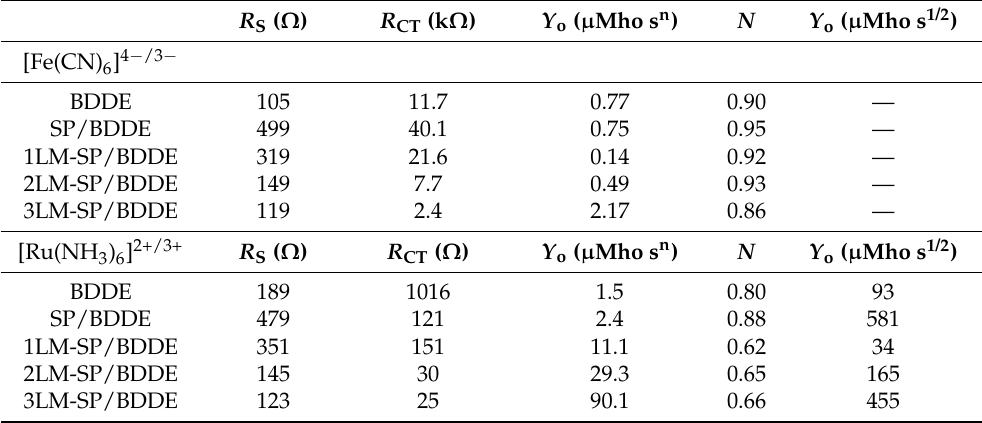
Table 5. The values of the particular elements of the electrical equivalent circuits (EECs) (R([R]/Q) for the Fe redox marker and R([RW]/Q) for the Ru redox marker calculated using the FRA simulation